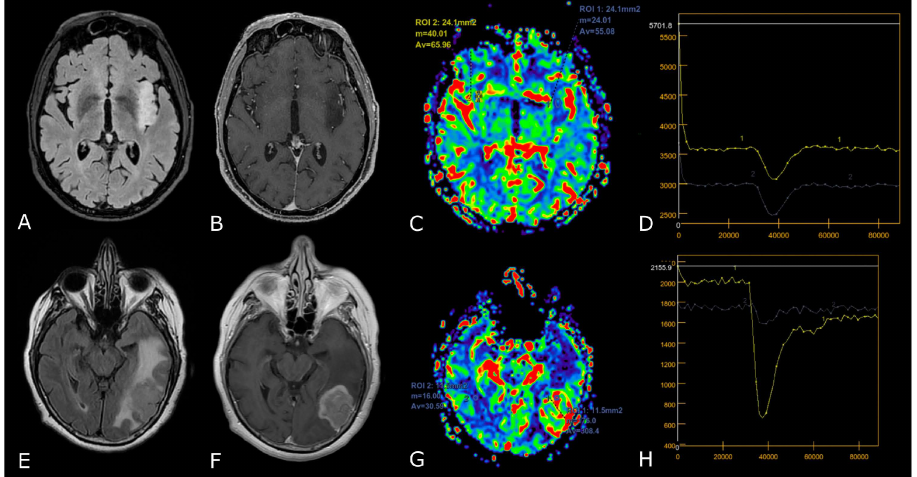
Figure 4. DSC-PWI in differentiating HGG from LGG. Axial T2-FLAIR ( A ) and post-contrast T1w ( B ) of a low grade IDH-mut left insular astrocytoma. DSC-PWI demonstrates normal rCBV ( C ) and complete return to baseline of the signal-intensity-time curve ( D ). The second row shows axial T2- FLAIR ( E ) and post-contrast T1w ( F ) of a left temporal-occipital GB. DSC-PWI demonstrates increased rCBV ( G ) and reduction of PSR consistent with BBB breakdown ( H